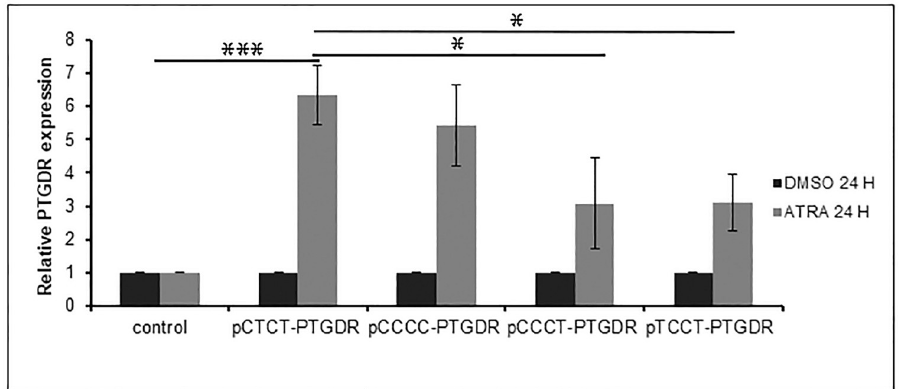
Fig 2. Quantitative real-time PCR analysis of PTGDR gene expression after ATRA or DMSO treatment. A549 cells transfected with pCTCT- PTGDR , pCCCC- PTGDR , pCCCT- PTGDR or pTCCT- PTGDR expression vectors. and with carrier DNA (control condition) were treated with 1 μ M ATRA or DMSO and collected after 24 followed by qPCR analysis as above mentioned. ��� P < 0.001 for transfected cells treated with ATRA versus DMSO at 24 (Wilcoxon test). � P < 0.05 for the CTCT- PTGDR transfected cells versus CCCT- and TCCT- PTGDR transfected cells (ANOVA